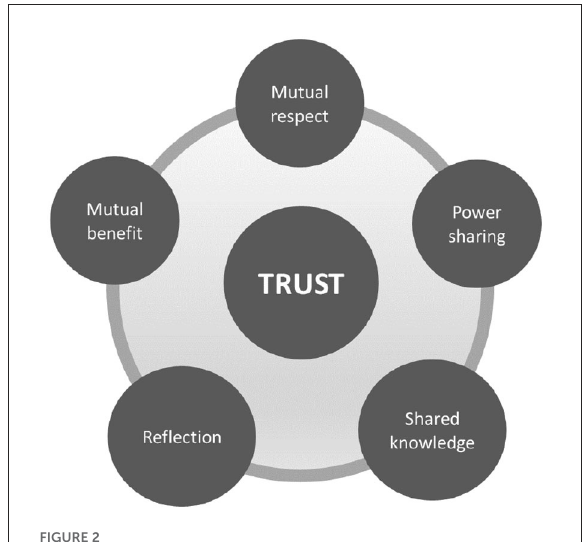
FIGURE2 Values of the Equal Health